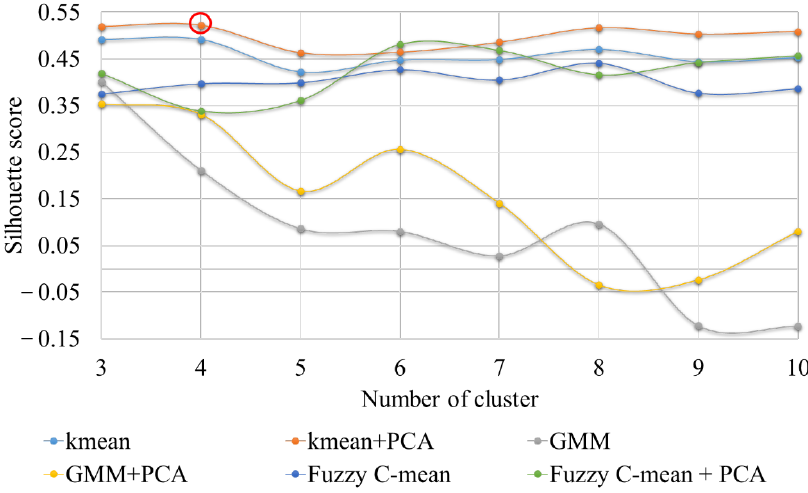
Figure 9. Silhouette score for each algorithm with respect to number of clusters.